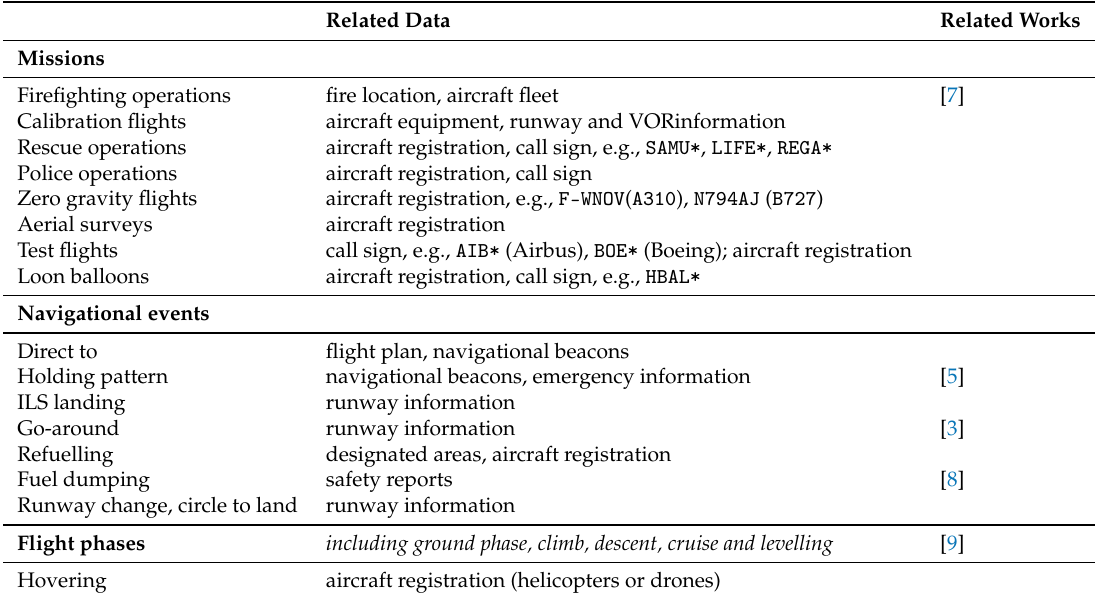
Table 1. A taxonomy of flight events. ILS, Instrument Landing